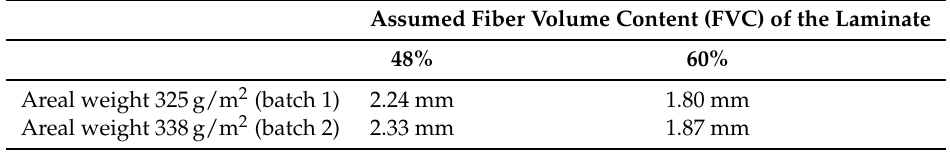
Table 1. Theoretical laminate thickness dependent on areal weight and fiber volume content for n L = 6